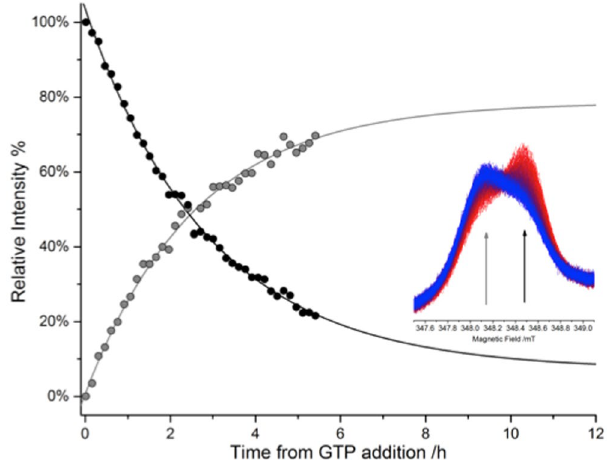
Figure 7. Curves of the relaxation to the initial state following addition of GTP (t = 0 h), detected as change of the EPR signal of spin label at site 88, at the field positions indicated by arrows in the inset. The dots represent respectively the percentage of recovery of the broader spectral component (grey dots) and of decay of the narrower spectral component (black). In the inset, the zoom of the EPR spectra (red t = 0 h; blue t = 5.5 h) with the positions used to obtain the kinetics shown by